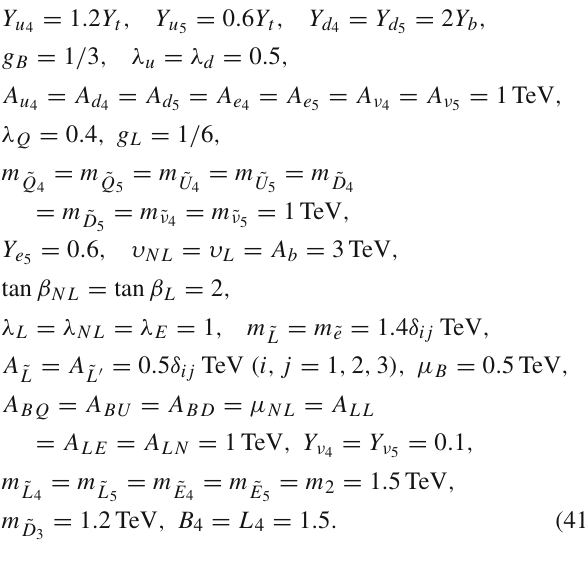
the experiment limits. The dot-dashed line(dotted line) in the right diagram denotes the Higgs mass m 0 A u . The dot-dashed line and dotted line increase mildly 5